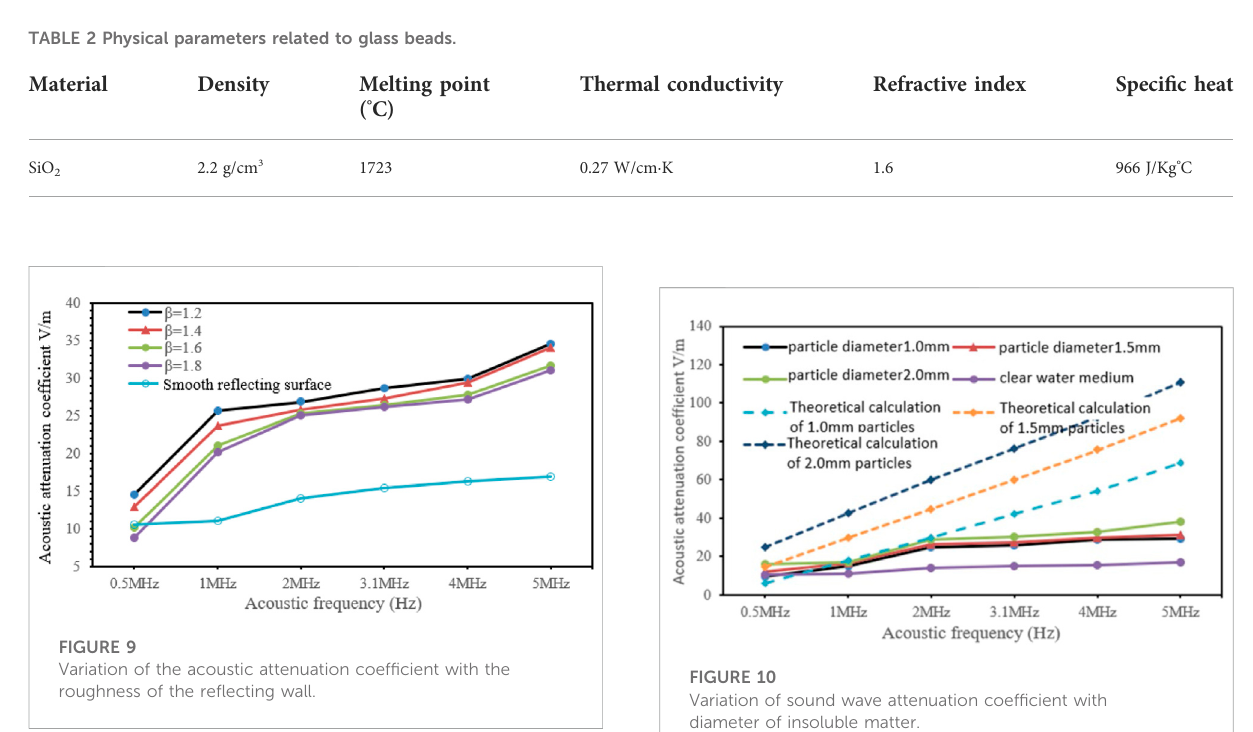
FIGURE 9 Variation of the acoustic attenuation coef fi cient with the roughness of the re fl ecting wall.